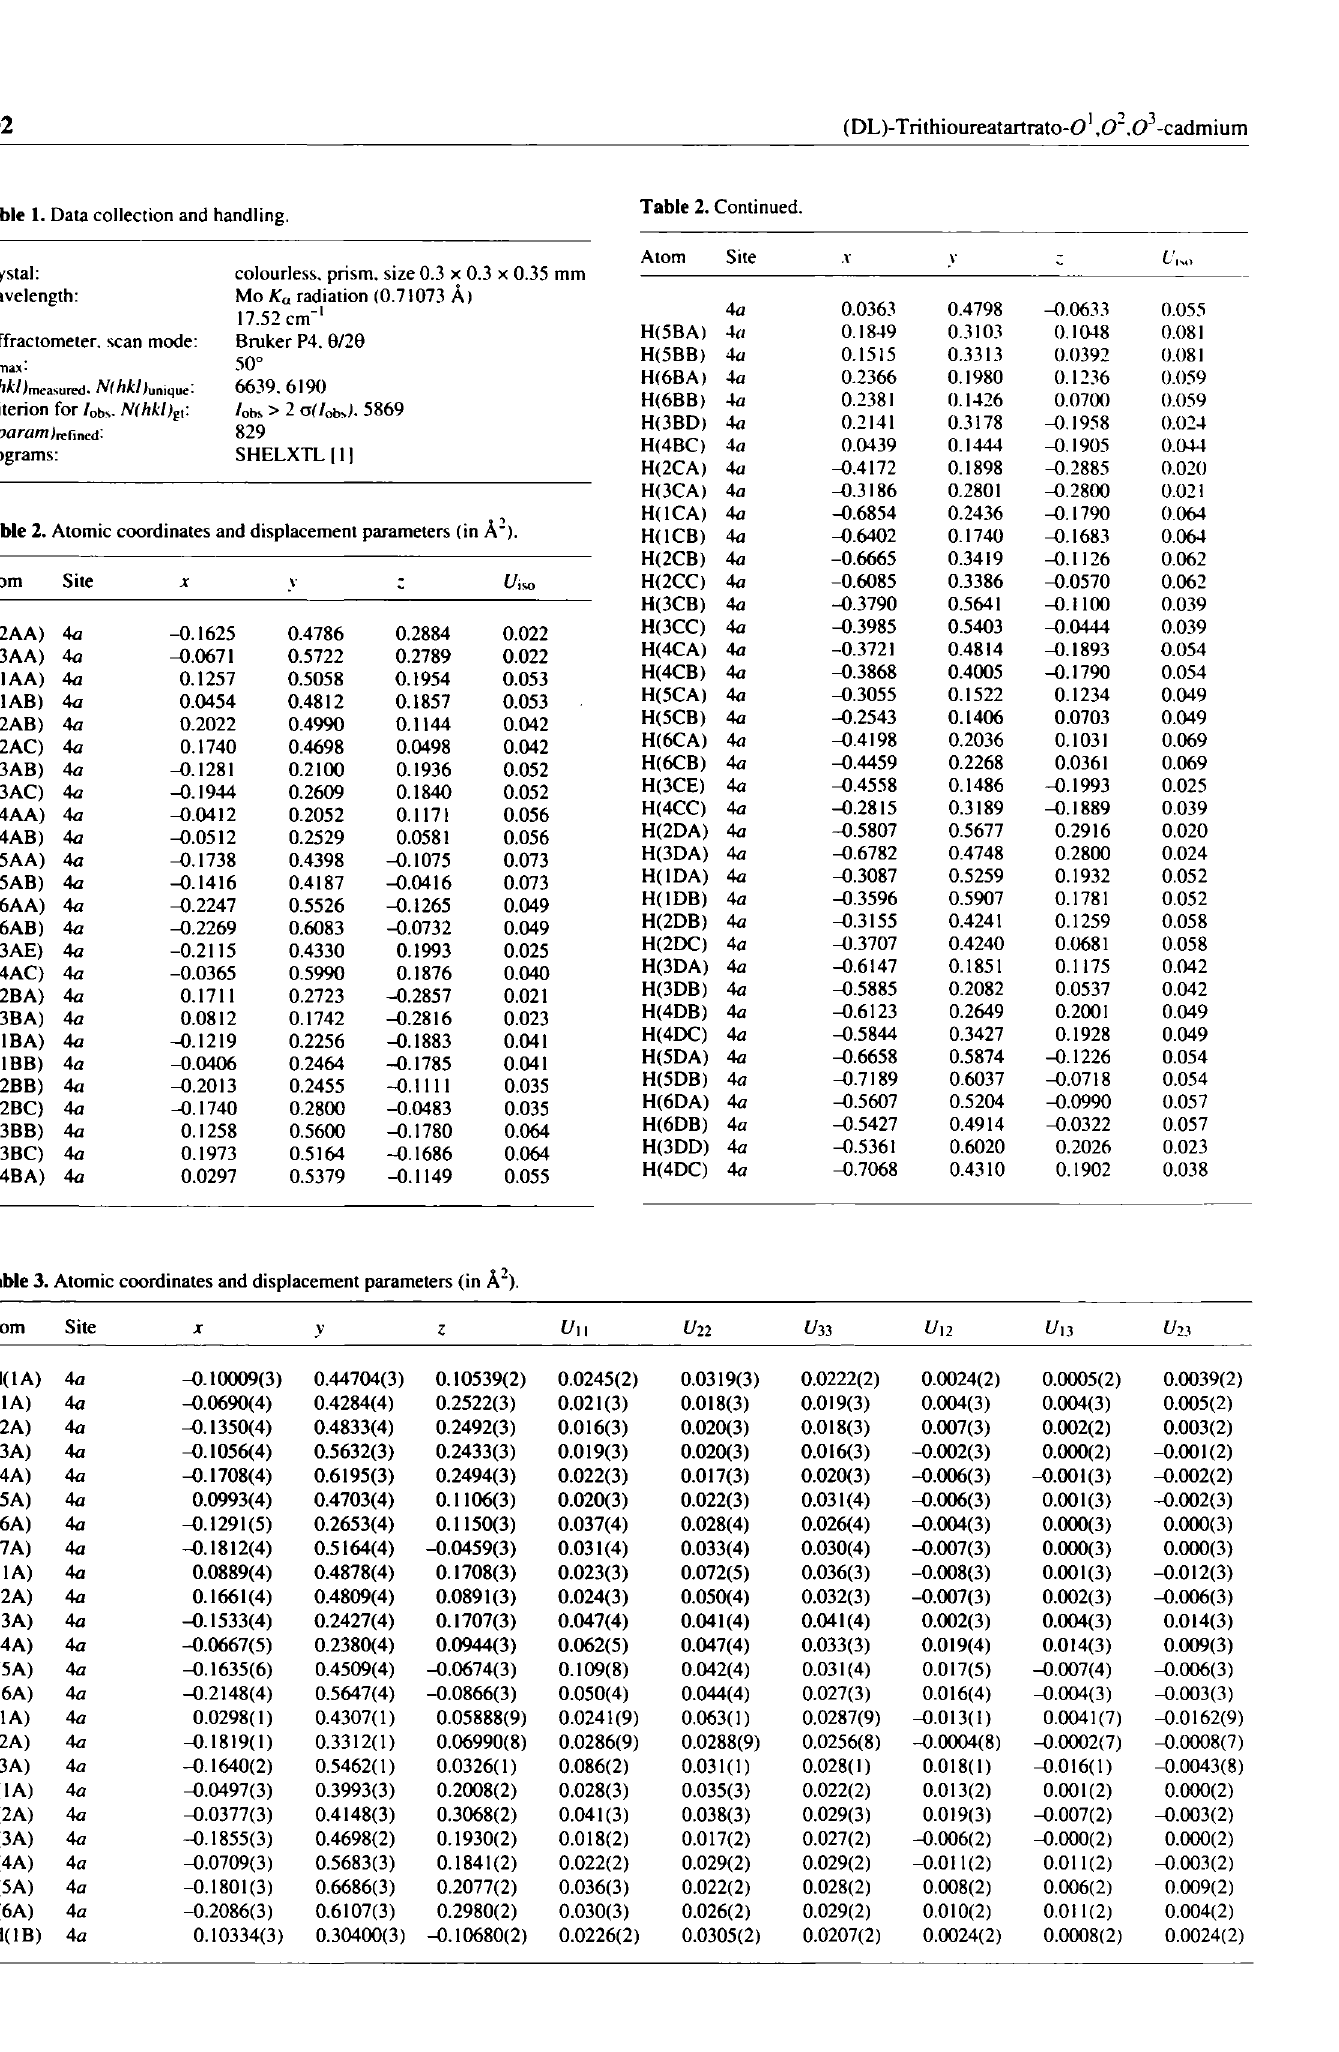
Table 3. Atomic coordinates and displacement parameters (in A 2